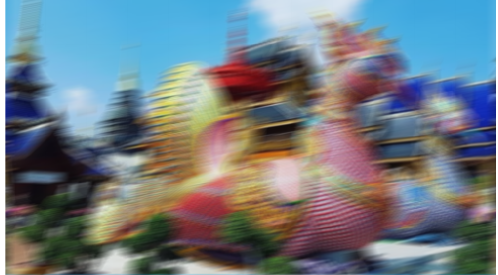
Figure 15. Three degraded RGB image by blurred matrices A 1 , A 2 , and A 3 , respectively.